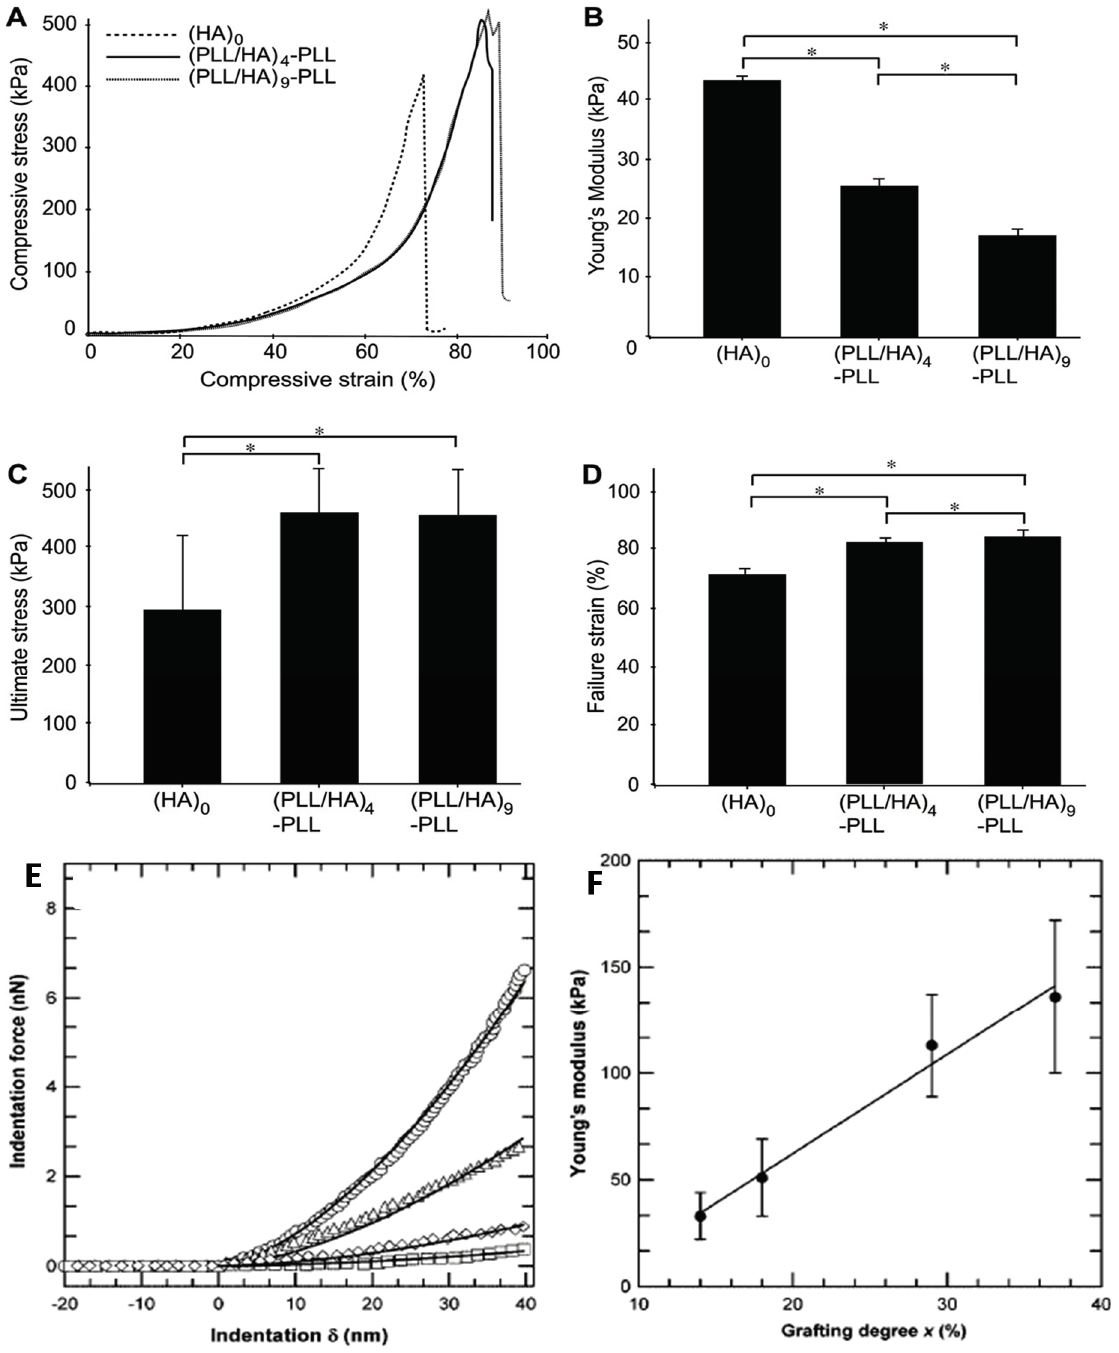
Figure 16. Mechanical properties of unmodified and PE coated HA MGs: ( A ) Compressive stress as a function of the strain; ( B ) Young’s modulus; ( C ) ultimate stress and ( D ) ultimate strain. Reproduced with permission from [37], copyright 2011, Elsevier; ( E ) Comparison of force vs. deformation curves measured by AFM for VB- g -HA/PLL films with grafting degrees of 14% (squares), 18% (tilted squares), 29% (triangles), and 37% (circles); ( F ) Variation of Young’s modulus extracted from force-indentation profiles of VB- g -HA/PLL vs. the grafting degree. Reproduced with permission from [29], copyright 2009, American Chemical